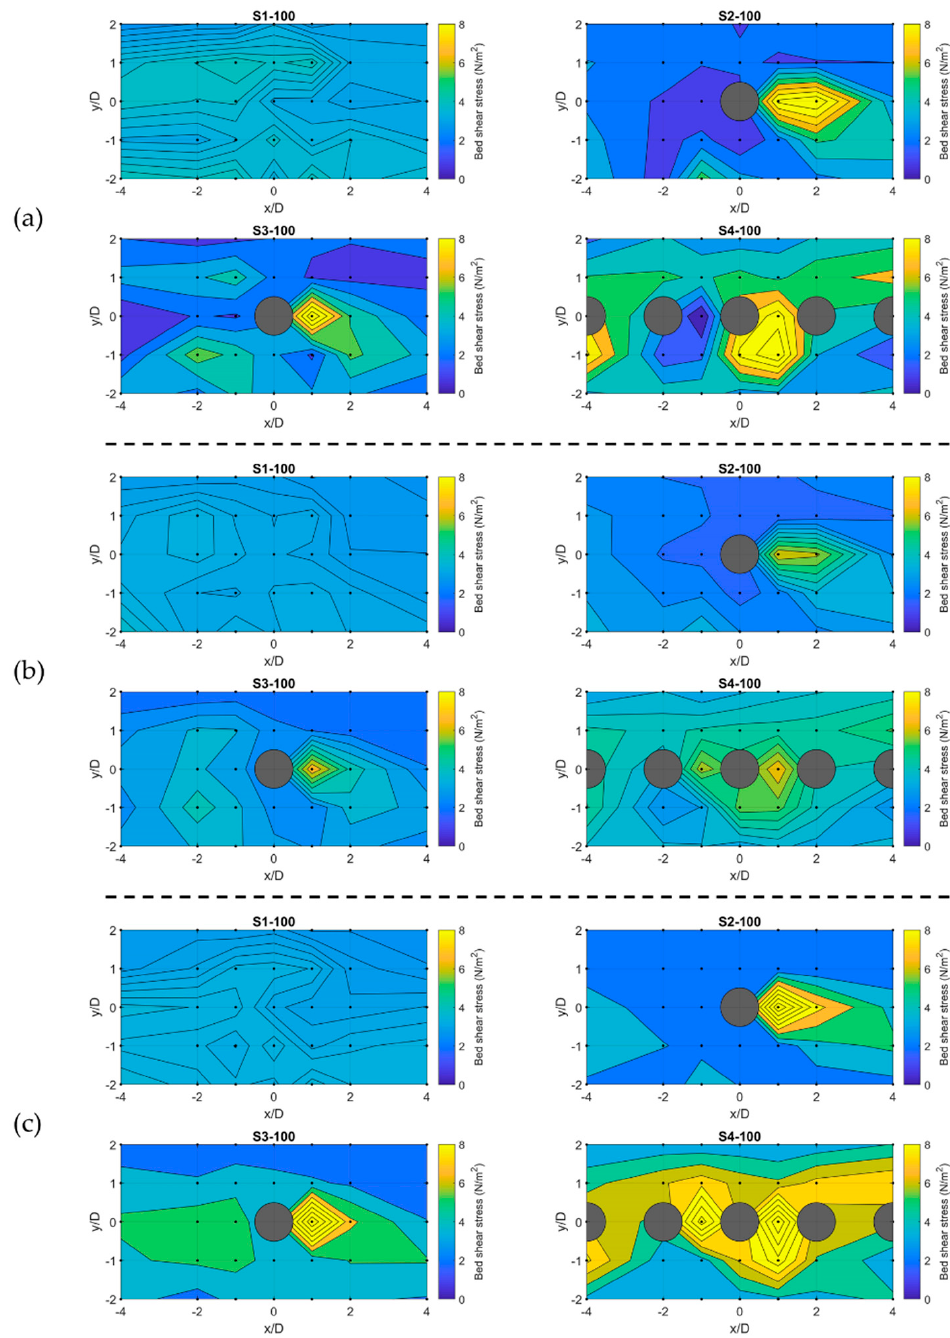
Figure 7. Contour plots of the estimated near-bed shear stress at 100 L / s (submerged condition) for ( a ) the Reynolds, ( b ) TKE, and ( c ) modified TKE methods. Gray circles show the idealized boulders, and small black dots represent the measuring points.